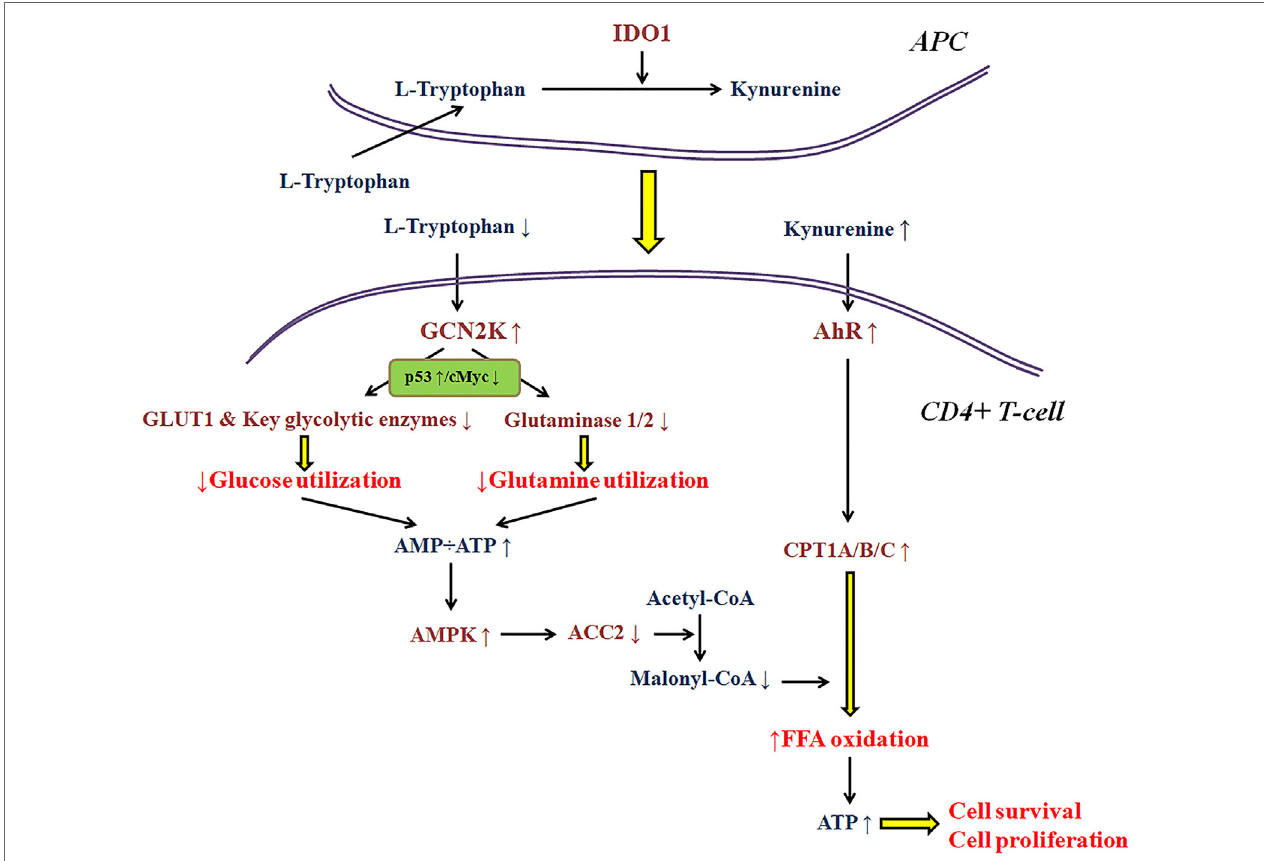
Figure 1 | A model about the effect of indoleamine 2,3-dioxygenase 1 (IDO1) on the utilization of the main energy sources by activated CD4 + T-cells. In the immune response microenvironment, IDO1 by degrading l -tryptophan along the kynurenine pathway activates general control non-derepressible 2 kinase (GCN2K) and aryl-hydrocarbon receptor (AhR). By upregulating the transcription factor p53 and downregulating the transcription factor c-Myc, activated GCN2K decreases the expression of glucose transporter 1 (GLUT1), key glycolytic enzymes, and glutaminases inhibiting the consumption of glucose and glutamine. The reduced utilization of these pivotal sources of energy by activated T-cells results in reduced ATP production. The latter activates AMP-activated protein kinase (AMPK), which phosphorylates and inactivates acetyl-CoA carboxylase 2 (ACC2) resulting in decreased production of the carnitine palmitoyltransferase I (CPT1) inhibitor malonyl-CoA. In parallel, activation of AhR increases the expression of all CPT1 isoenzymes. Since CPT1 controls free fatty acid oxidation, these IDO-induced alterations promote free fatty acid oxidation as an alternative fuel for ATP production, supplying the required energy for CD4 + T-cell survival and proliferation.